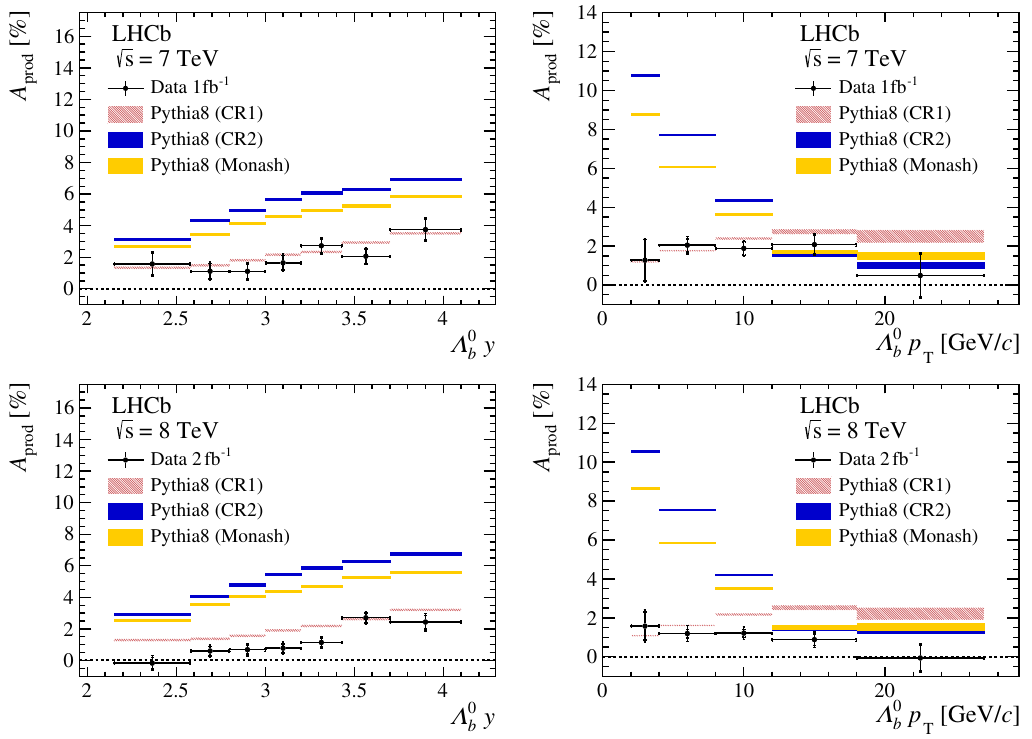
Figure 10 . Comparison of the (cid:3) 0 production asymmetry predicted by the various Pythia models, b where CR1 refers to the QCD-inspired model and CR2 refers to the gluon-move model, and the measured production asymmetries. Results versus (cid:3) 0 (left) rapidity y and (right) p T are shown b for centre-of-mass energies of (top) p s = 7 TeV and (bottom) p s = 8 TeV. Uncertainties on the predictions are due to limited simulation sample